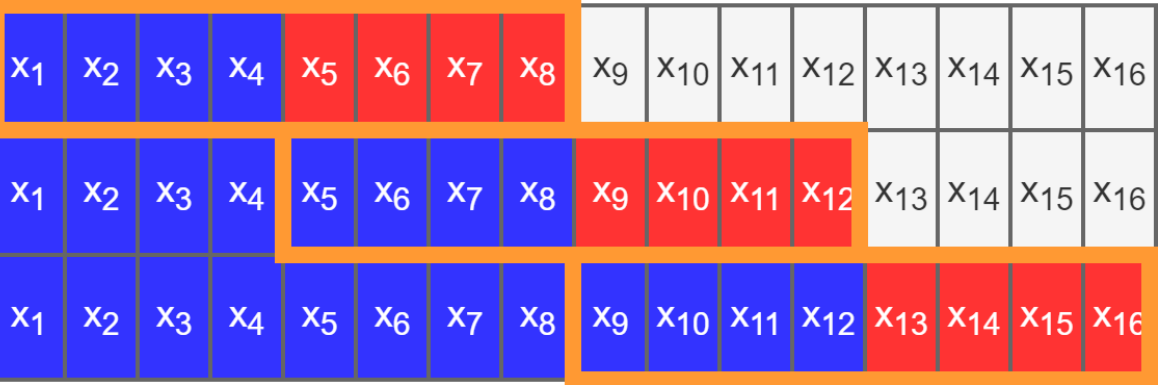
Figure 5. Illustration of the sliding window operation for Seq2Seq LSTM on toy data. Blue boxes denoted as the input data for encoder, red boxes denoted as the ground truth to be predicted by decoder, orange rectangles denoted as the sliding